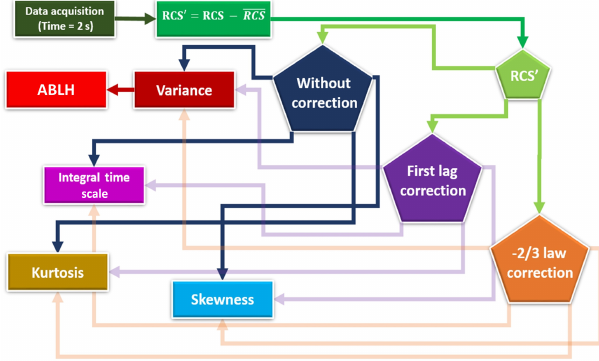
Figure 1. Methodological description of data analysis performed for elastic lidar